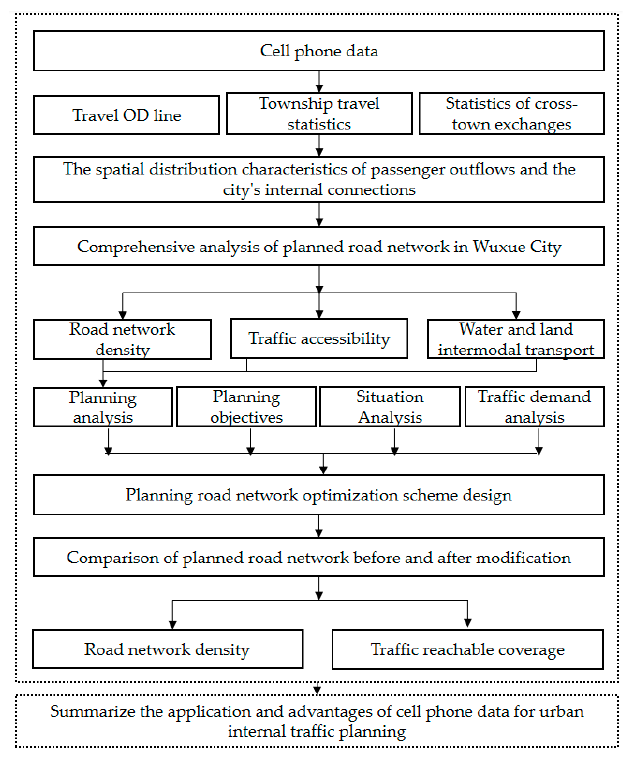
Figure 5. Research